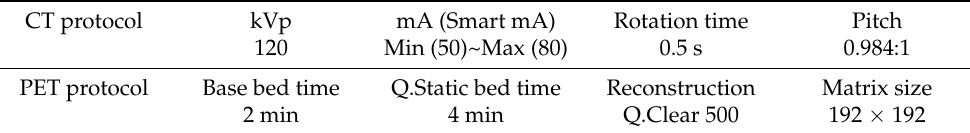
Table 1. 18 F-FDG PET/CT protocol for phantom